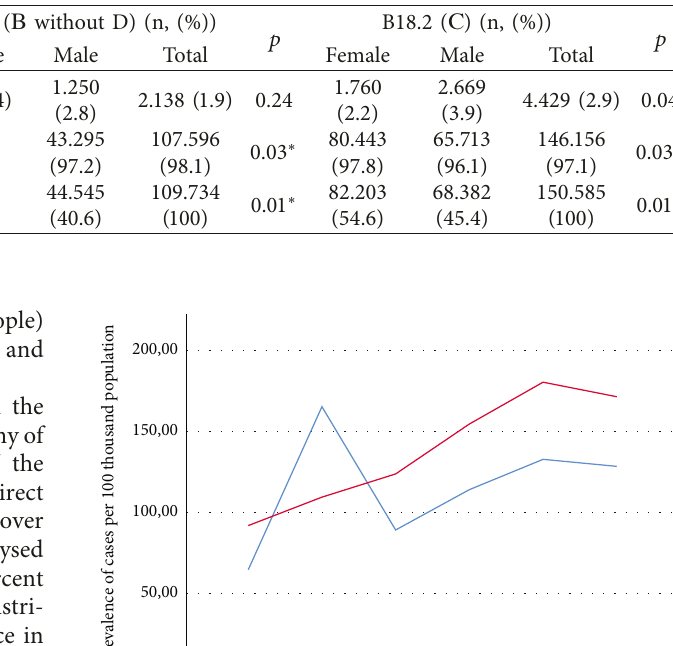
Table 1: Distribution of viral hepatitis B, D, and C by age and sex.